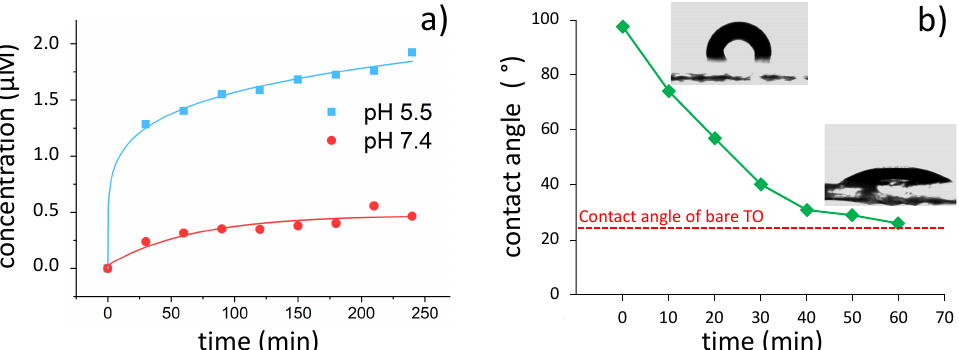
Figure 5. ( a ) Release test with the grafted film at different pH values. ( b ) Regeneration test of the porous film with images of contact angle values (inset); the contact angle of the pristine titania film (red line) is indicated as a reference. In ( a , b ) lines were added as a guide for the eyes.